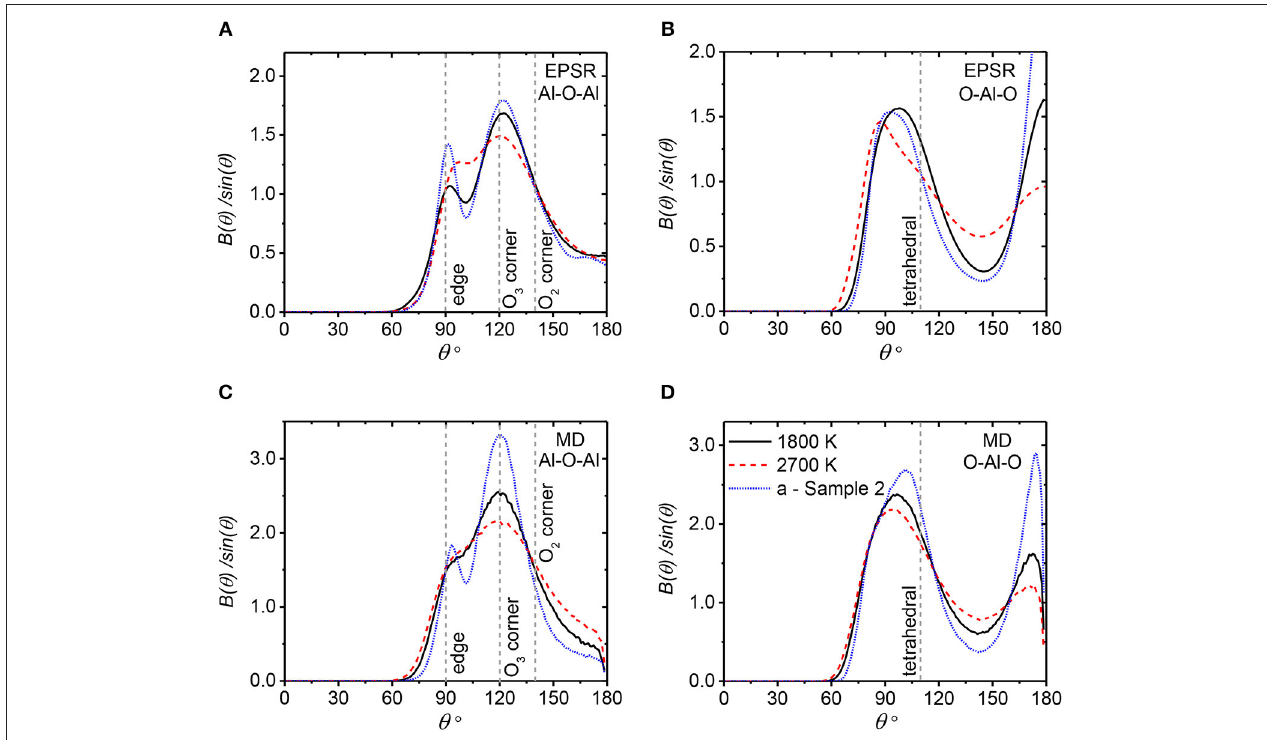
FIGURE 10 | The bond angle distributions for amorphous alumina sample 2, and liquid alumina at the highest and lowest experimental temperatures of 2,700 and 1,817K. EPSR results using a density of 3.05g cm − 3 (A,B) and MD models (C,D) . (A,C) show the Al-O-Al angle distribution; (B,D) display the O-Al-O angle distribution. The dashed lines denote bond angles for some typical polyhedral arrangements (Skinner et al.,